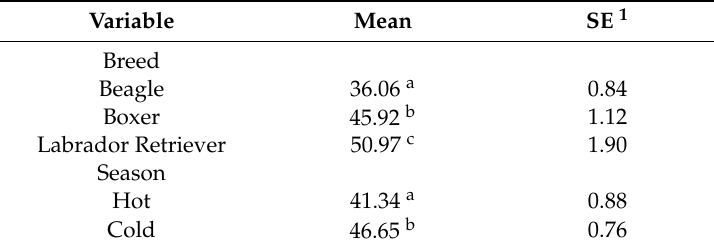
Table 4. Adjusted mean comparison between di ff erent kennel dog breeds and seasons for food intake previously corrected by their body weight (intake g / animals weight 0.75 ).